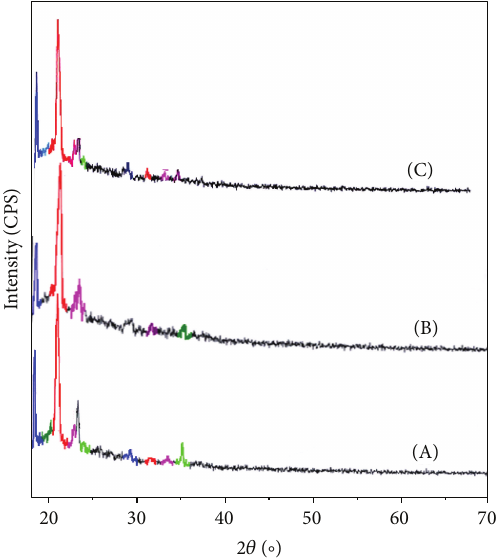
Figure 6: Combined XRD pattern of PEO/Salt composite system with 1.98 (A), 3.3 (B), 4.62 (C), and 5.94 (D) wt% of CPMMT.